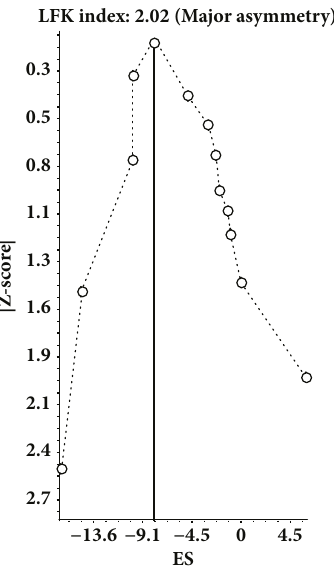
Figure 1: Doi plot and LFK index for small-study effects based on changes in resting SBP as a result of resistance